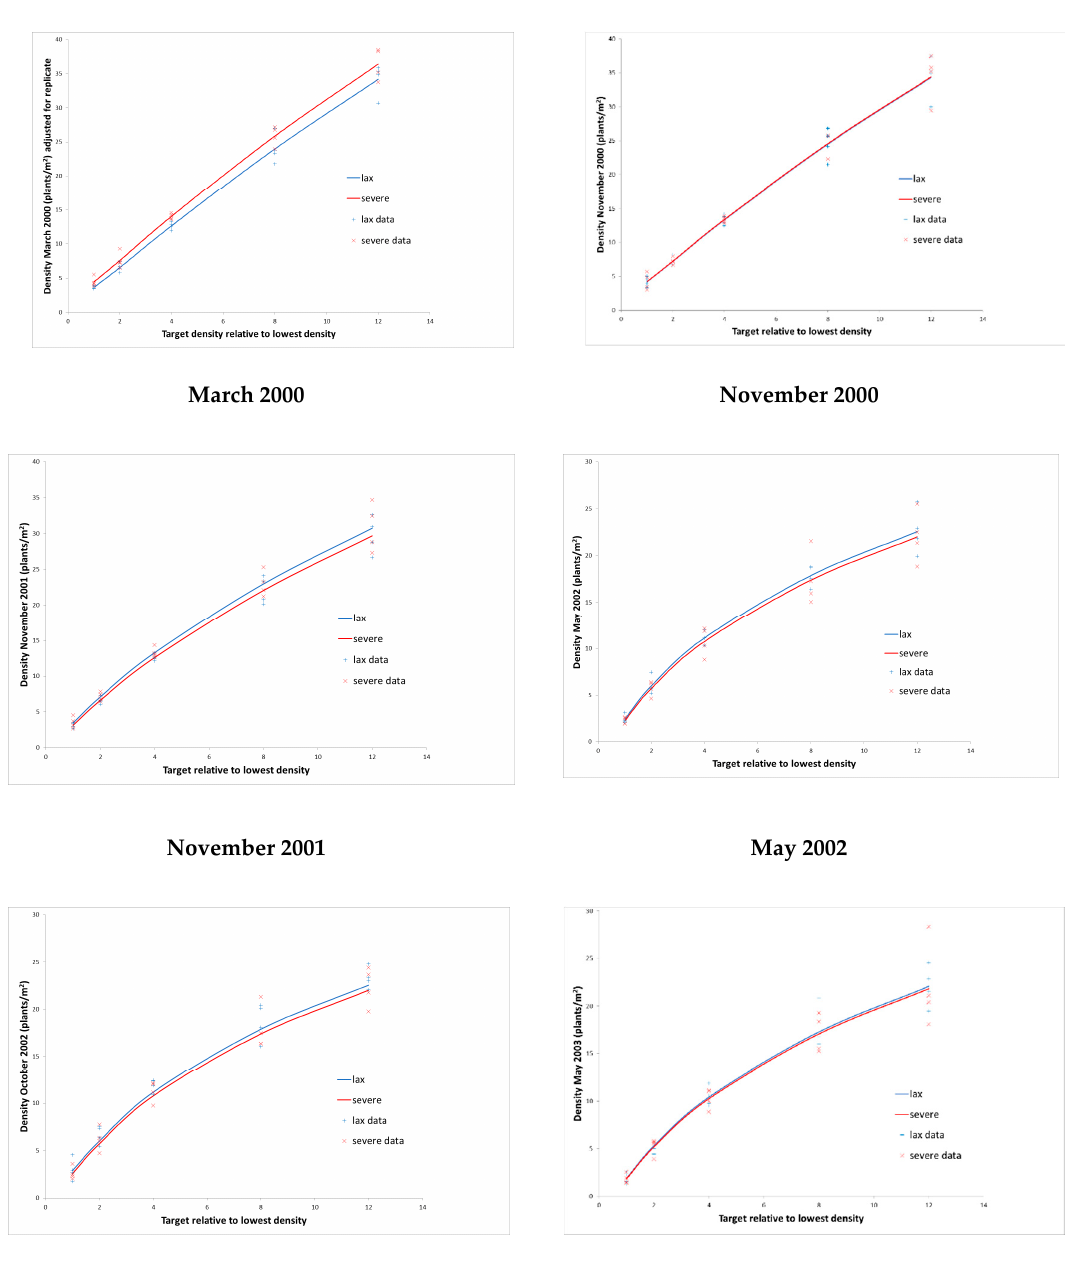
Figure 5. Crown density, as a response to target defoliation relative to the lowest density treatment, for the lax and severe cutting treatments at Burraja from 6 assessments between June 1999 and March 2003. The response curves represent the square root of crown density being fitted as two parallel response curves, one curve for each of the two cutting frequencies, that are quadratic in the logarithm of relative target density, prior to back-transforming onto the crown density (y-axis) and relative target density (x-axis) scales. Individual points represent plot values that have been adjusted for block on the square root scale of crown density.